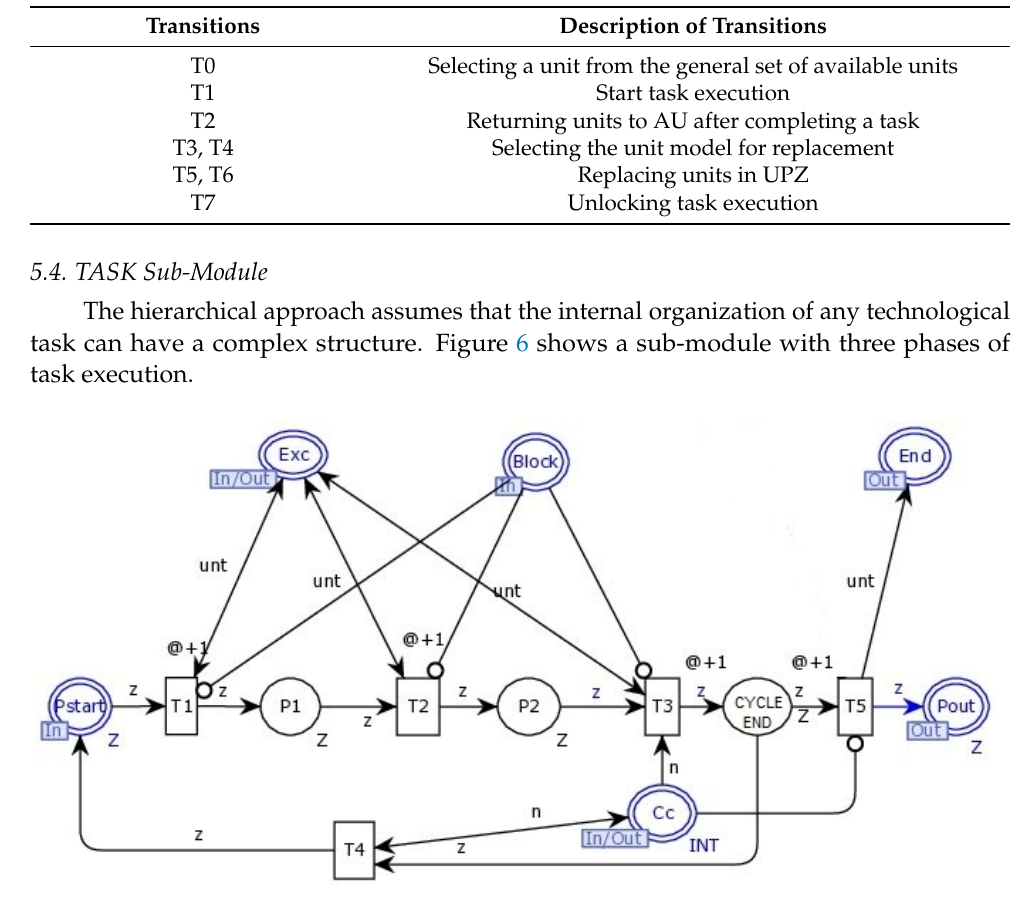
Table 3. Transitions of ZExec module.